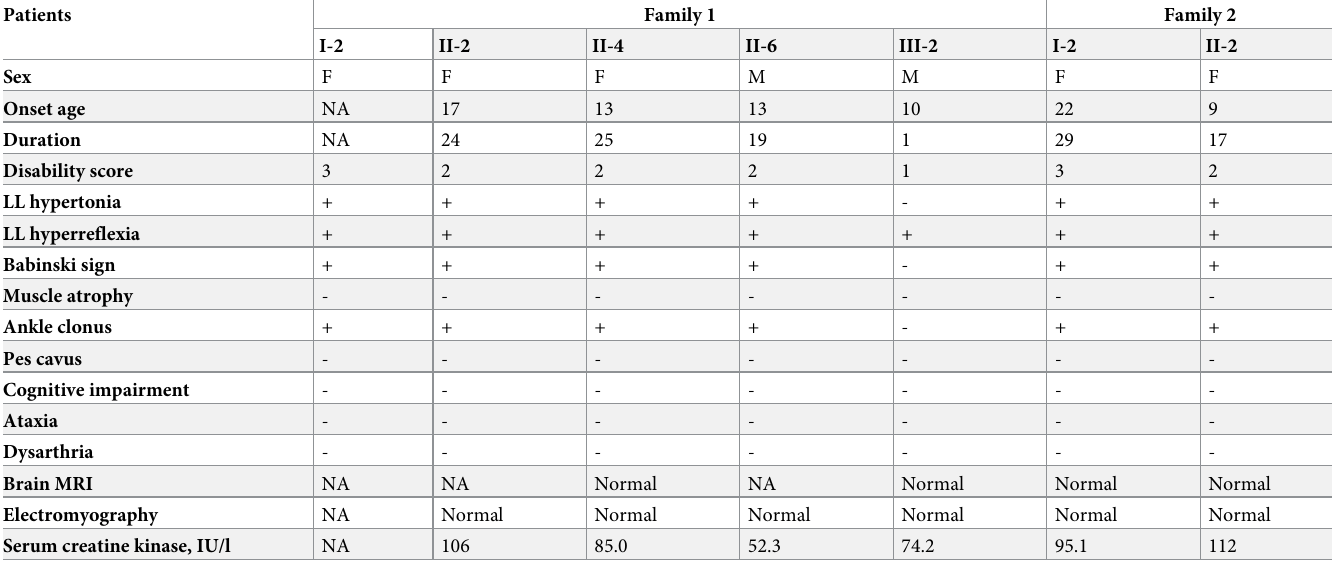
Table 1. Clinical features in HSP patients of the two families. Patients